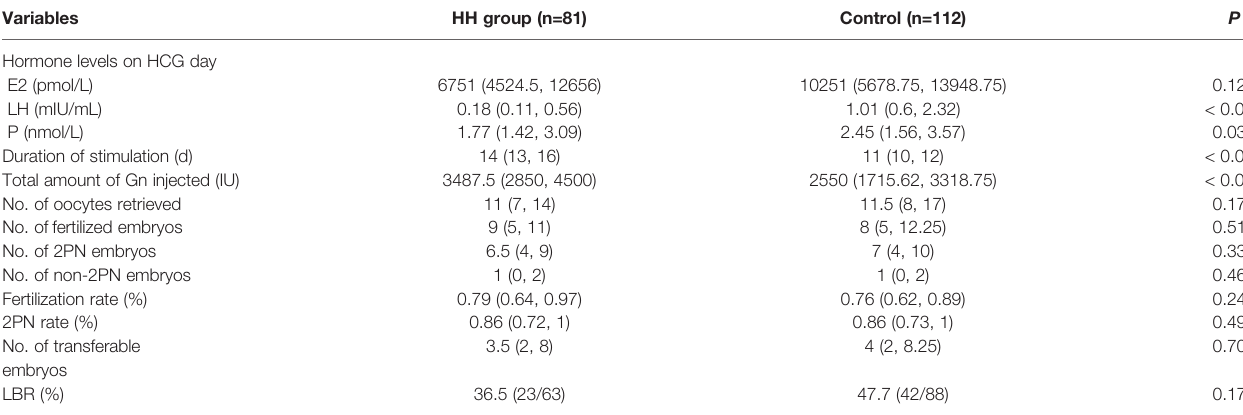
TABLE 2 | Comparison of cycle characteristics between hypogonadotropic hypogonadism (HH) and control groups.